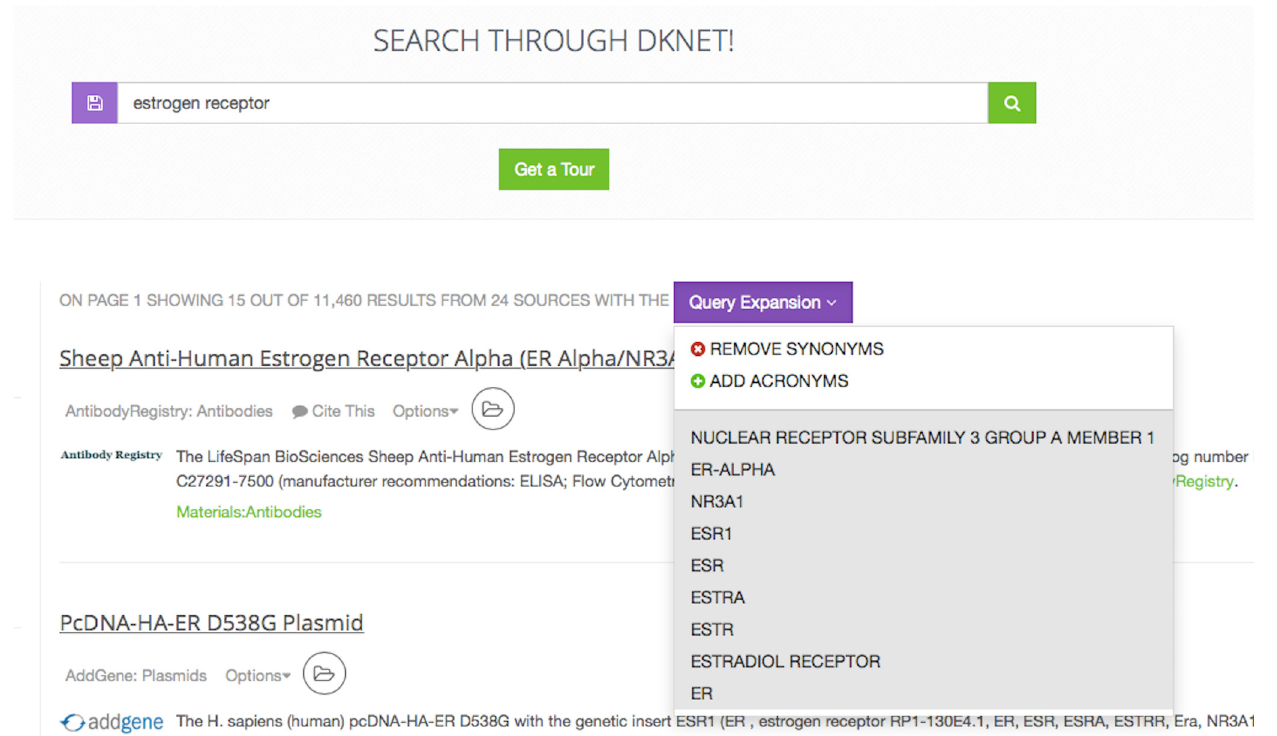
Fig 4. Query expansion. The included terms are additional terms used to query the data sources based on the term expansion process using knowledge from the ontology. The most common expansion includes synonyms and common abbreviations of a term.